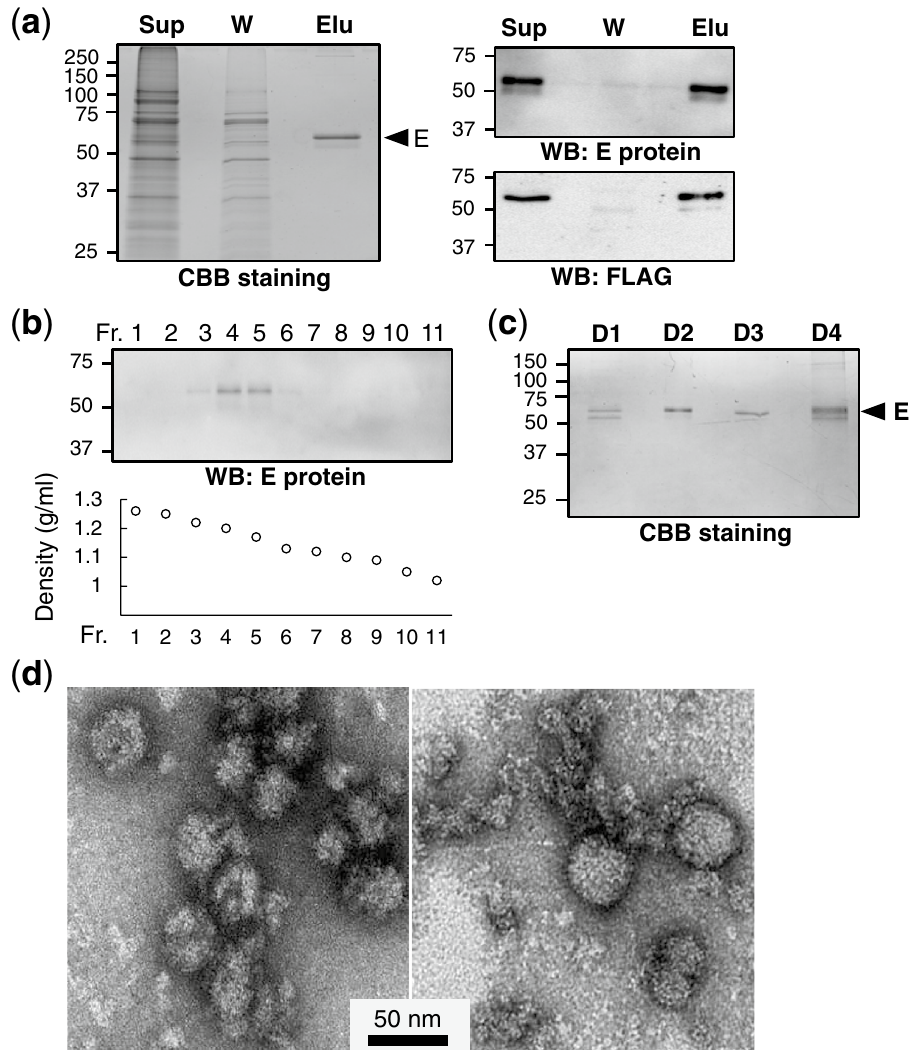
Figure 3. Purification and characterization of FLAG-inserted DENV-LPs. ( a ) FLAG-inserted DENV-2 VLP was purified by utilizing magnetic beads conjugated with the anti-FLAG antibody. Aliquots of crude culture supernatant from FL-273-expressing cells (Sup), washing buffer used after VLP-beads binding (W) and eluate from the VLP-bound beads (Elu) were separated by SDS-PAGE, followed by CBB staining (left) and western blotting with anti-E protein antibody (upper light) and anti-FLAG antibody (lower right). ( b ) The density of DENV-LP was determined by sucrose density gradient centrifugation. Aliquots of each fraction (Fr.1–11) were analyzed by SDS-PAGE and western blotting. ( c ) Purified FLAG-inserted VLPs derived from DENV-1, -2, -3 and -4 analyzed by SDS-PAGE and CBB staining. Uncropped images of western blotting and CBB staining pictures in Fig. 3 are included in supplementary Fig. 3. ( d ) DENV-2 VLP samples were stained with uranyl acetate solution and observed by TEM. The scale bar shows the length of 50